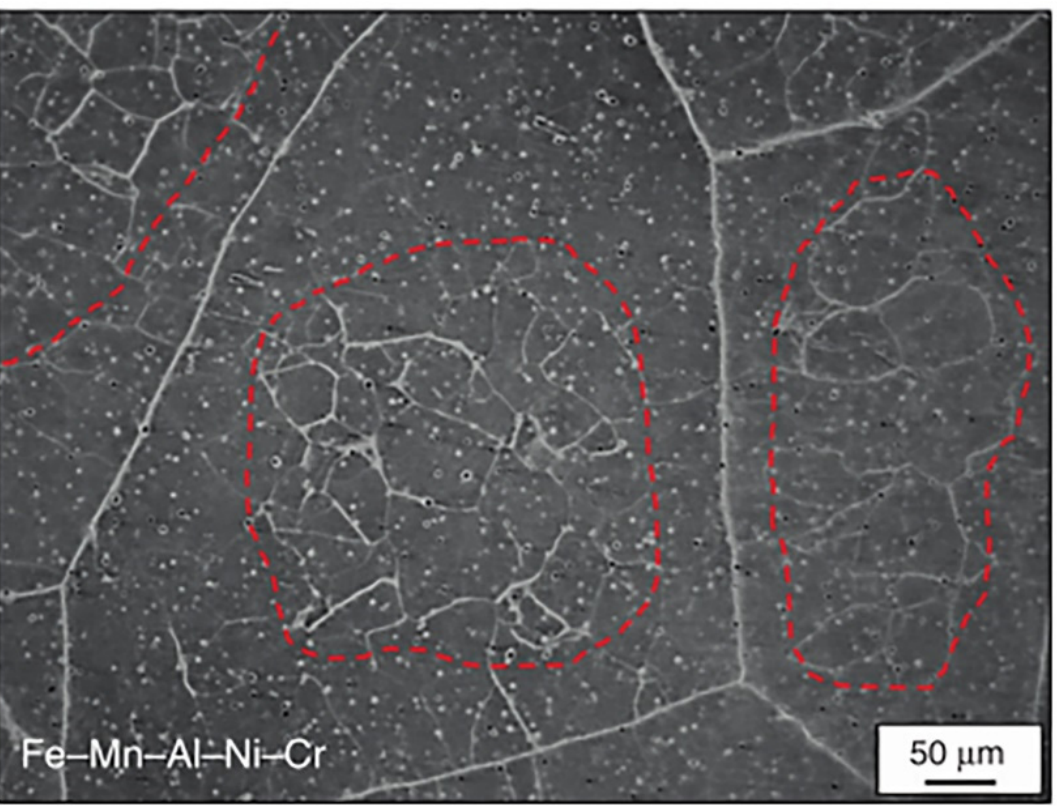
Figure 10. Photomicrograph of Fe-Mn-Al-Ni-Cr after single-cycle heat treatment and quenching [109]. Reprinted with permission from Ref. [109]. Copyright 2019 Springer Nature.